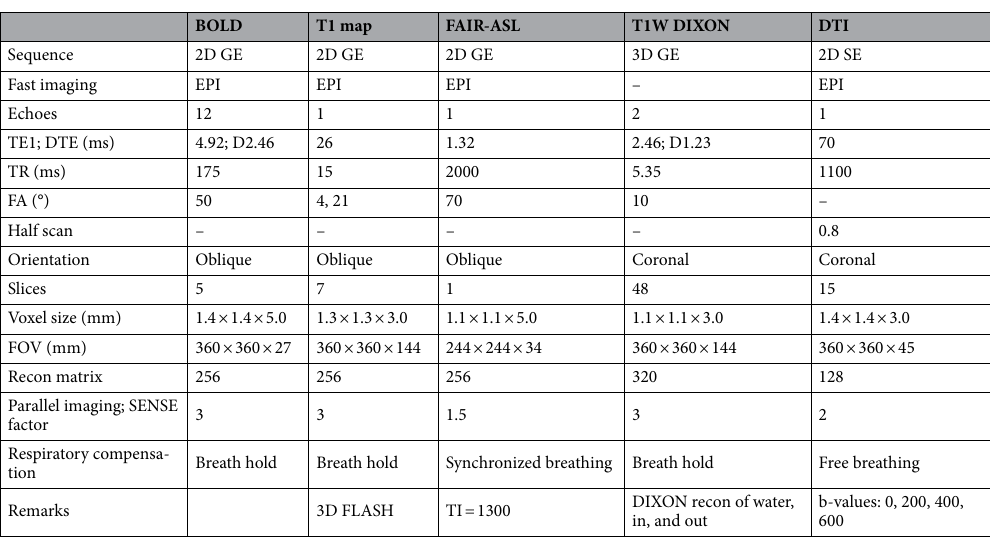
Table 5. MRI scanning parameters. BOLD blood oxygenation level dependent, FAIR-ASL flow attenuated inversion recovery arterial spin labelling, T1W T1 weighted, DTI diffusion tensor imaging, GE spoiled gradient echo, SE spin-echo, EPI echo planar imaging, TE echo time, TR repetition time, FA flip angle, FOV field of view, TI inversion time, recon